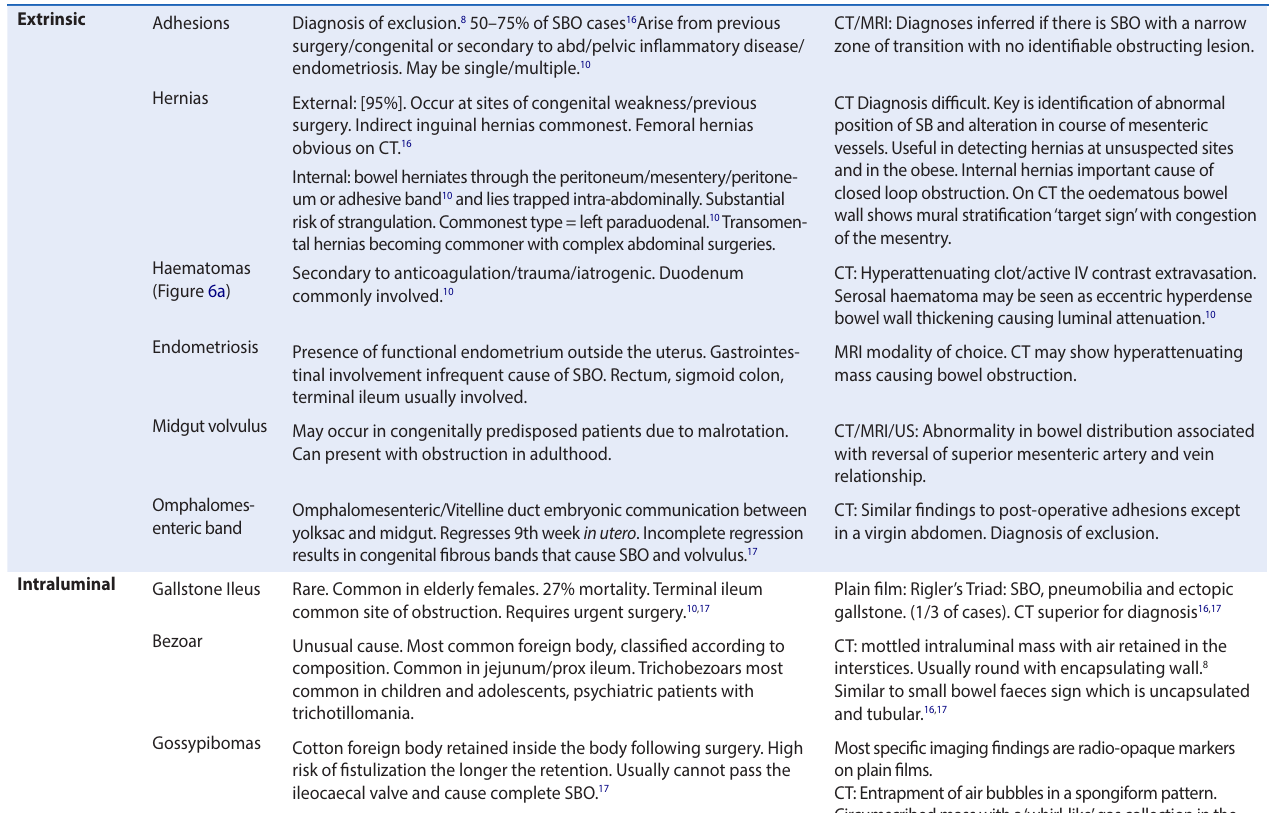
Table 2: Causes of SBO